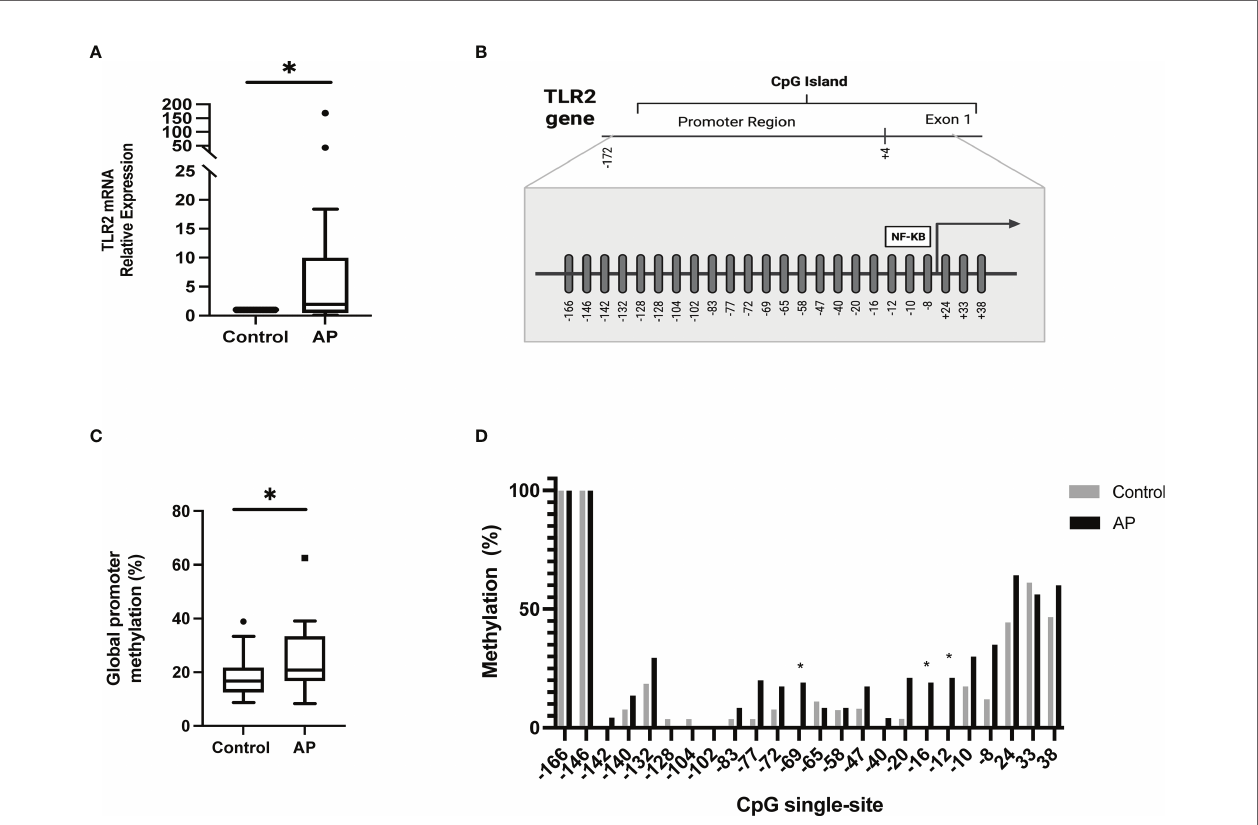
FIGURE 2 | Expression levels and methylation pro fi le of TLR2 in PBMC from apical periodontitis and control individuals. (A) mRNA relative expression of TLR2. The expression data were normalized to 18S rRNA and relative to controls, using the differences between 2 – DD CT. *p = 0.013. (B) Schematic representation of the human CpG single-sites from TLR2 gene promoter. (C) Global promoter methylation frequency (%). *p=0.043 (D) CpG single-site methylation frequency (%). AP apical